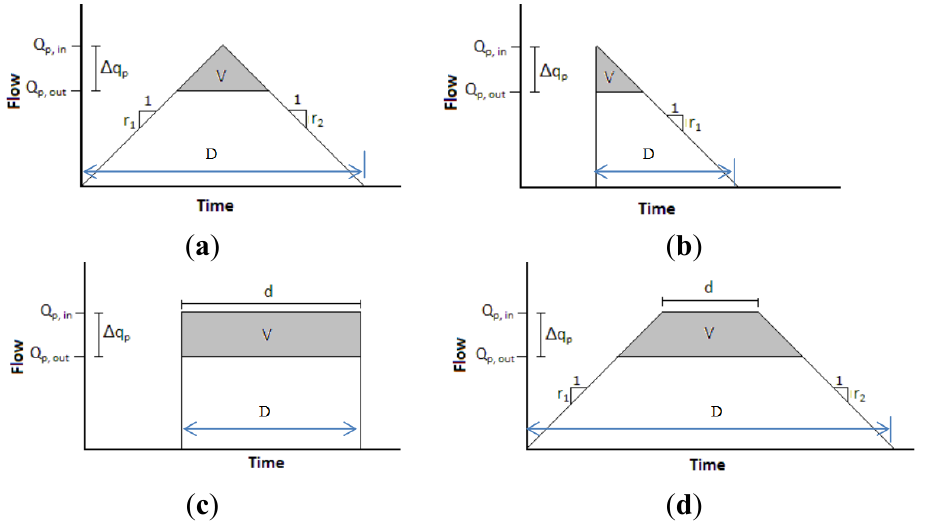
Figure 1. Four simple hydrographs and optimal peak flow reductions for a fixed